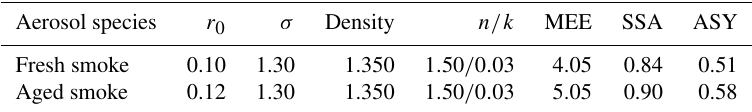
Table 1. Parameters describing aerosol components used in the ALADIN-Climate model for the two smoke tracers and the resulting optical properties.